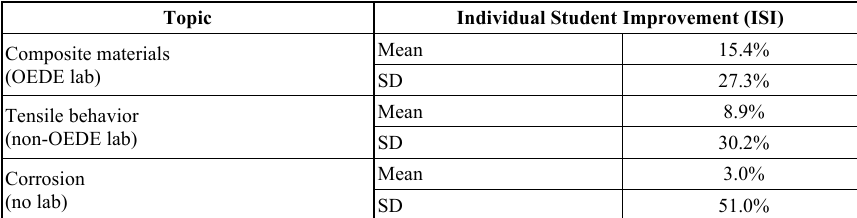
Table 2. Summary of Individual Student Improvement (negative values indicate a decline) Topic Individual Student Improvement